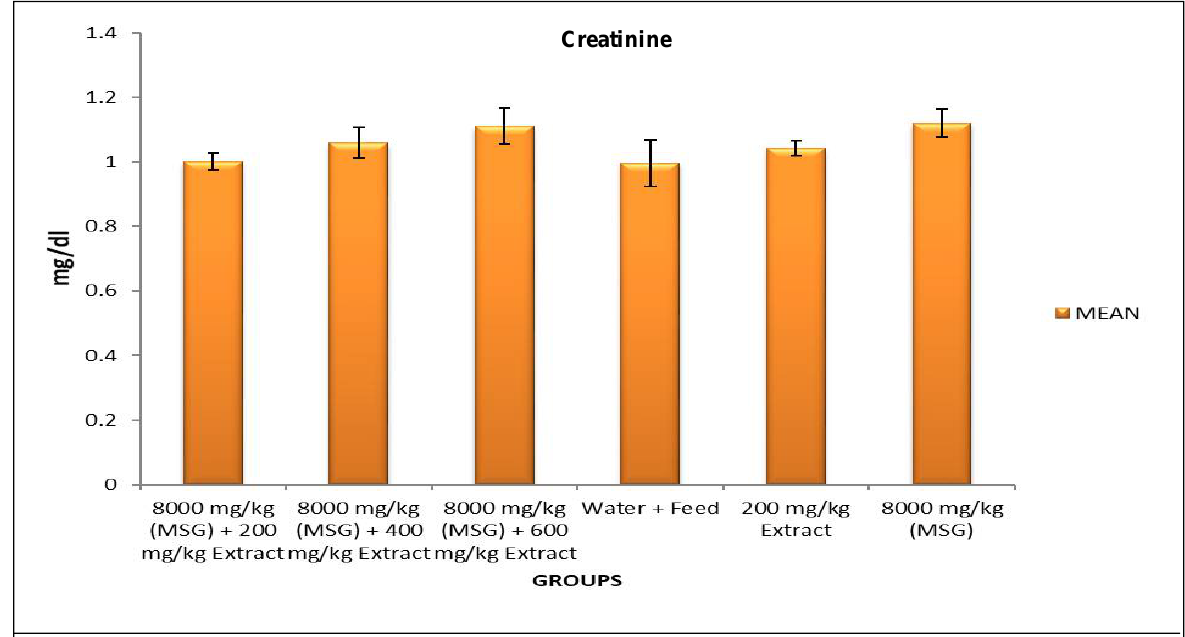
Figure 8: Effect of methanol extract of N. laevis on creatinine concentration (mg/dl) of the